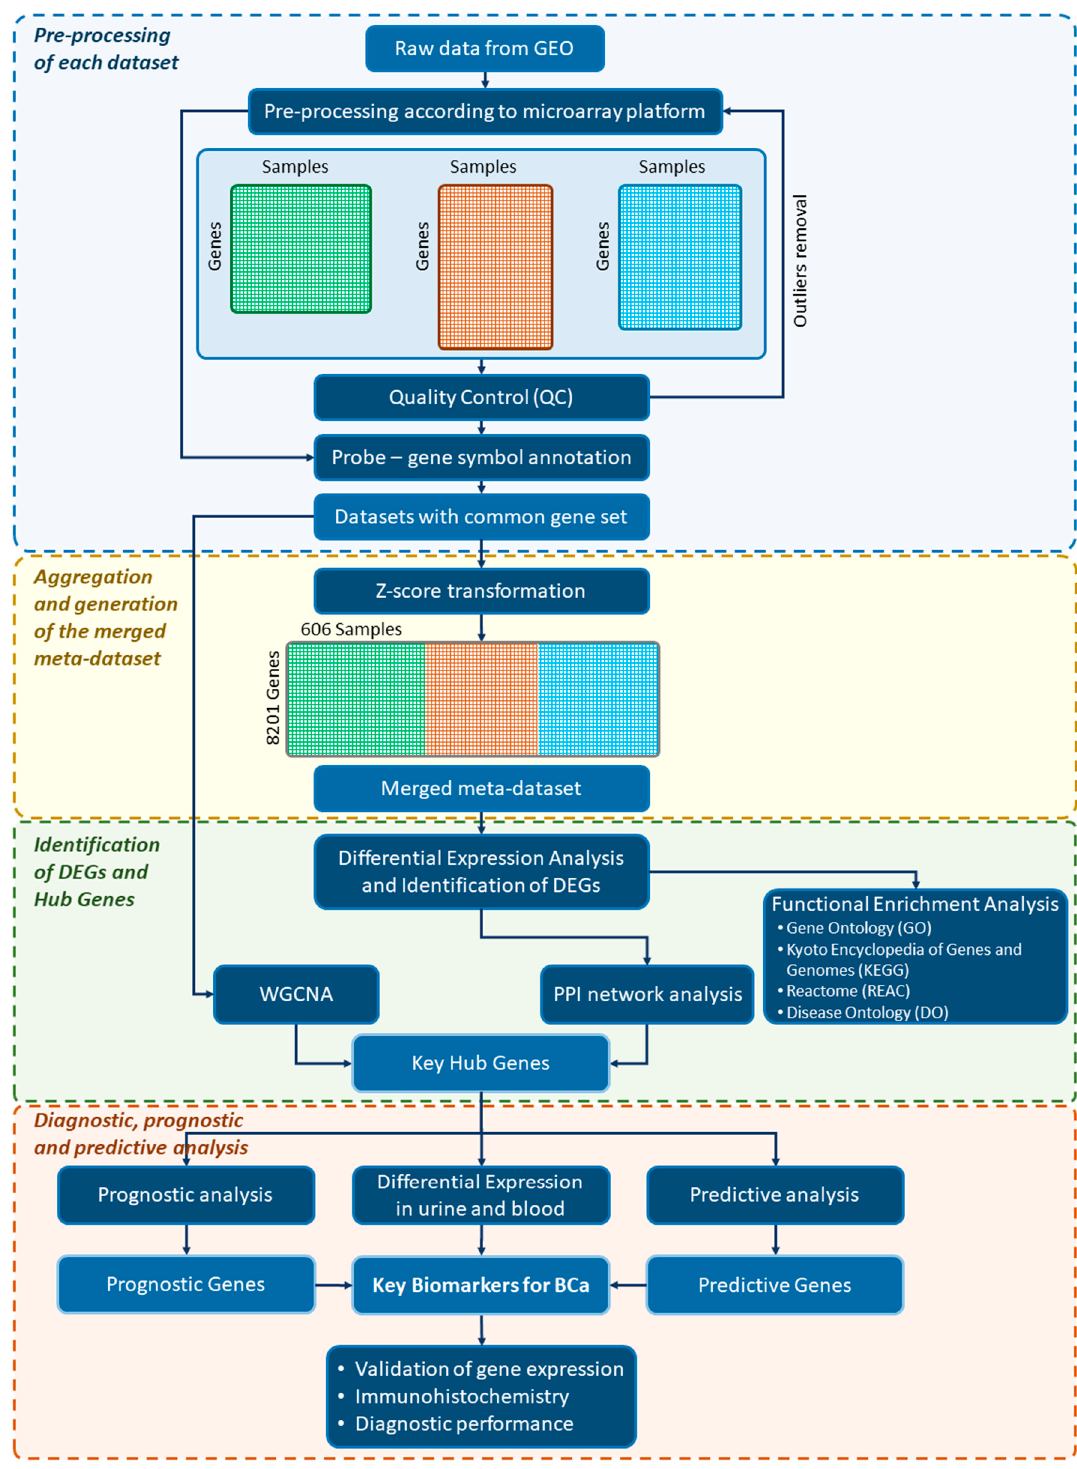
Figure 1. The overall study design and workflow of the integrative bioinformatics analysis of this study.